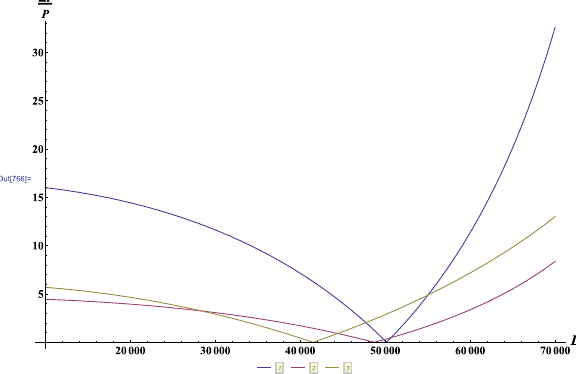
Fig. 5 Same analysis of Fig. 1, but for LIV parameters δ f 32 = δ f 21 = 4 . 5 × 10 − 27 and for neutrino energy E = 100 GeV